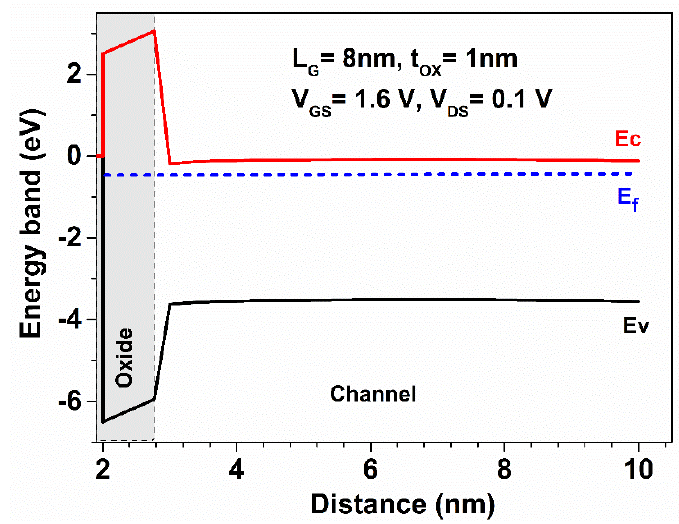
Figure 3. Energy Band diagram for the vertical cross-section of GaN-SOI FinFET.